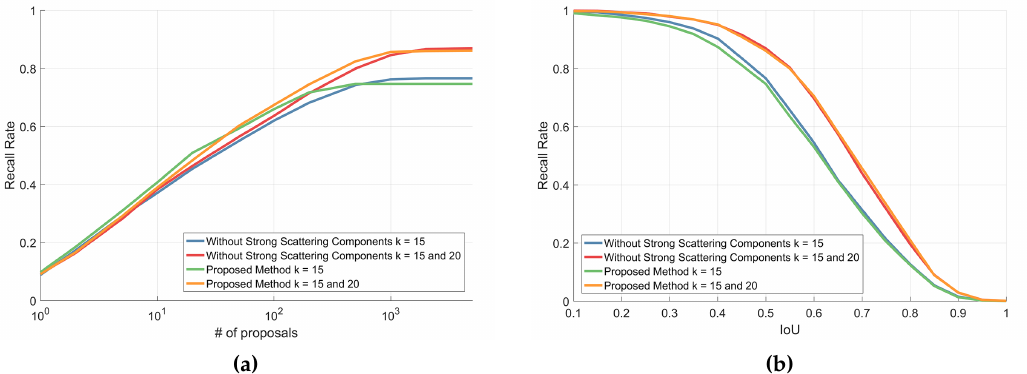
Figure 7. The recall using our method and the variants without utilization of strong scattering components information. ( a ) the curves measuring the recall versus numbers of ship proposals; ( b ) the curves measuring the recall versus